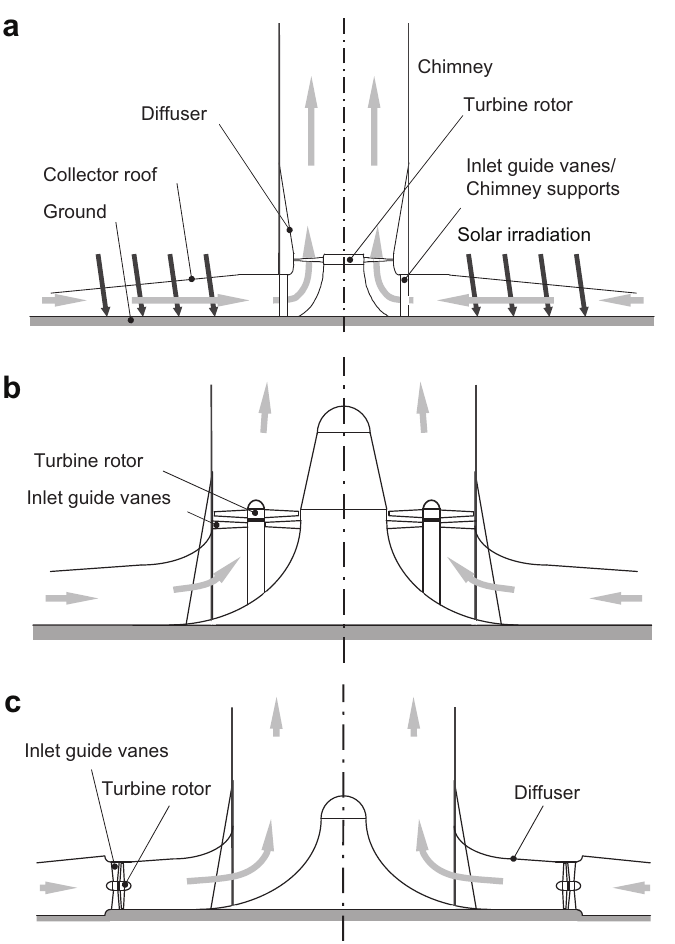
Fig. 1. Schematic of a solar chimney power plant. Figure 2. Configurations of axial turbines in an SCPP; ( a ) single vertical axis (VA) turbine, ( b ) multiple VA turbines, and ( c ) multiple horizontal axis (HA) turbines from Fluri [2].